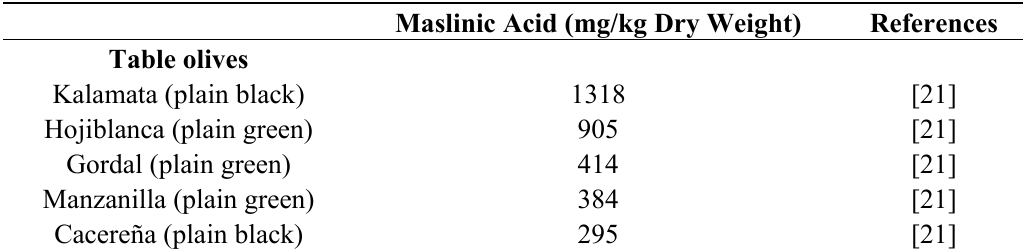
Table 1. Maslinic acid content in edible